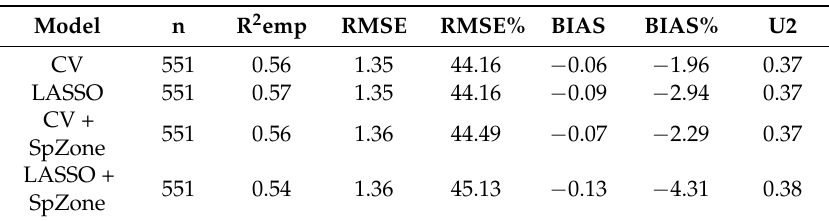
Table 4. Goodness-of-fit statistics for the natural logarithm of annual increment in diameter at breast height (AIDBH, mm year − 1 ) for the selected models using test data.